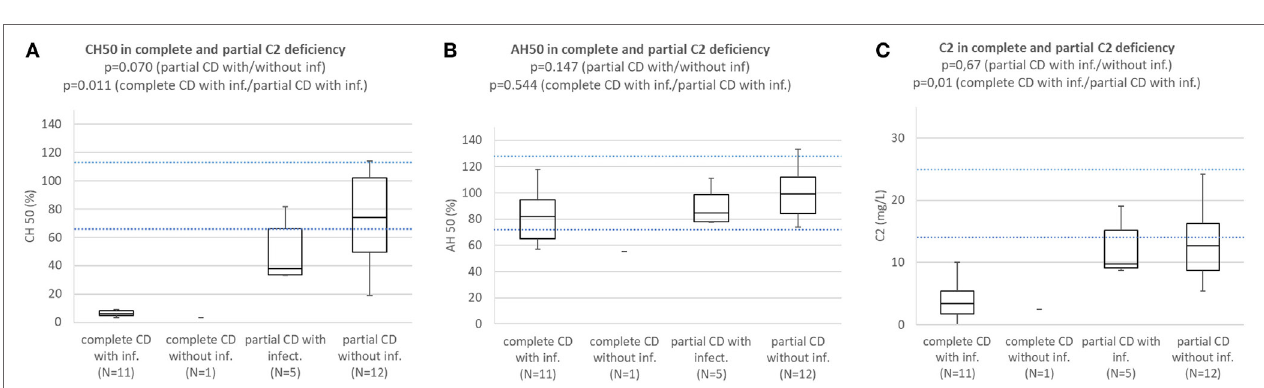
FigUre 4 | (a) Comparison of CH50 between patients with complete C2 deficiency with infections, complete C2 deficiency without infections patients with partial C2 deficiency with infections, and subjects with partial C2 deficiency without infections. (B) Comparison of AH50 between patients with complete C2 deficiency with infections, complete C2 deficiency without infections, patients with partial C2 deficiency with infections, and subjects with partial C2 deficiency without infections. (c) Comparison of C2 concentration between patients with complete C2 deficiency with infections, complete C2 deficiency without infections, patients with partial C2 deficiency with infections, and subjects with partial C2 deficiency without infections.